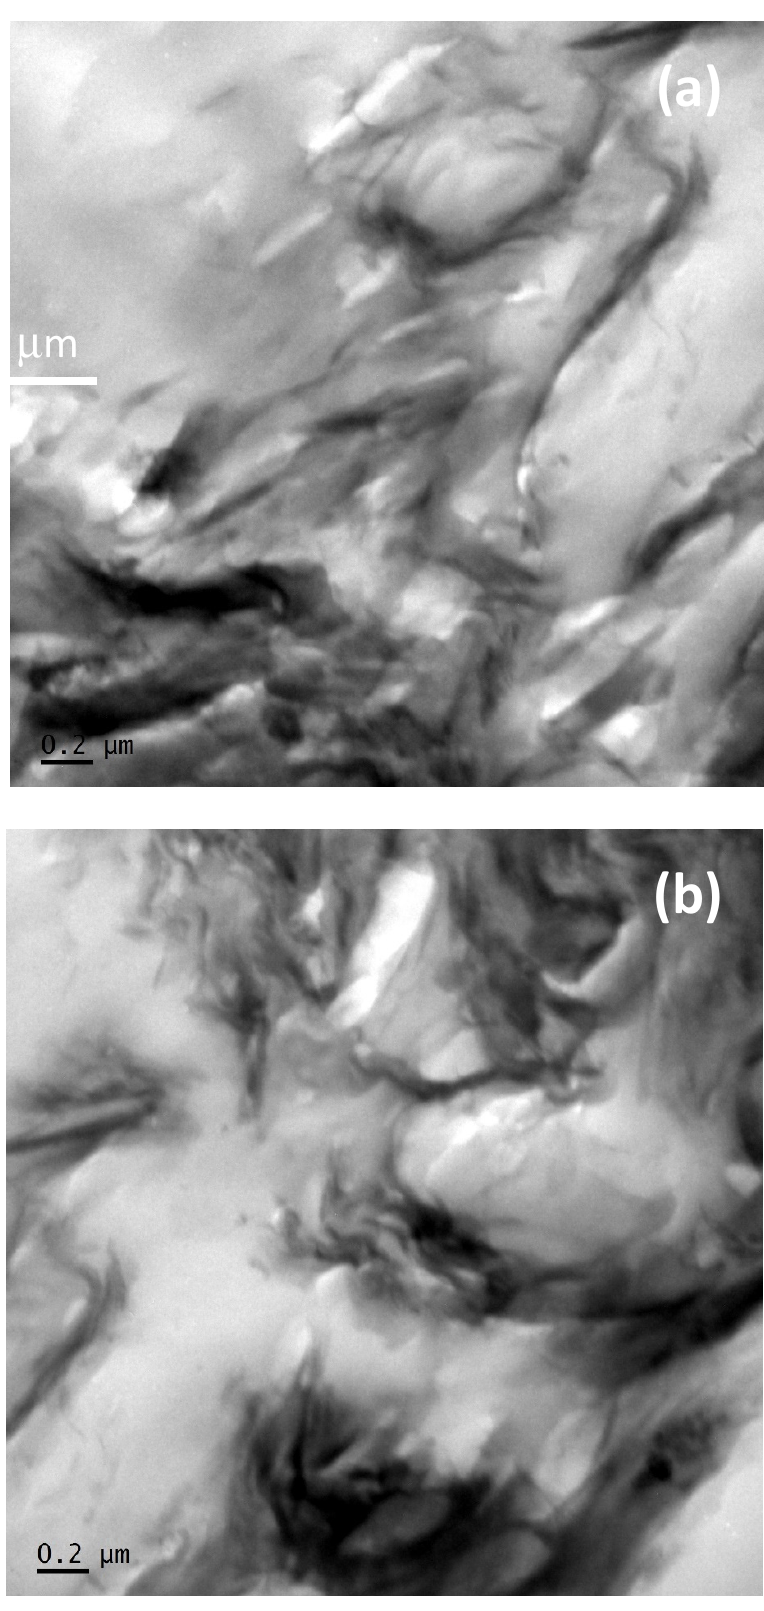
Figure 2. TEM image of epoxy with ( a ) 2 wt.% CNF; ( b ) 5 wt.% CNF-filled nanocomposites.